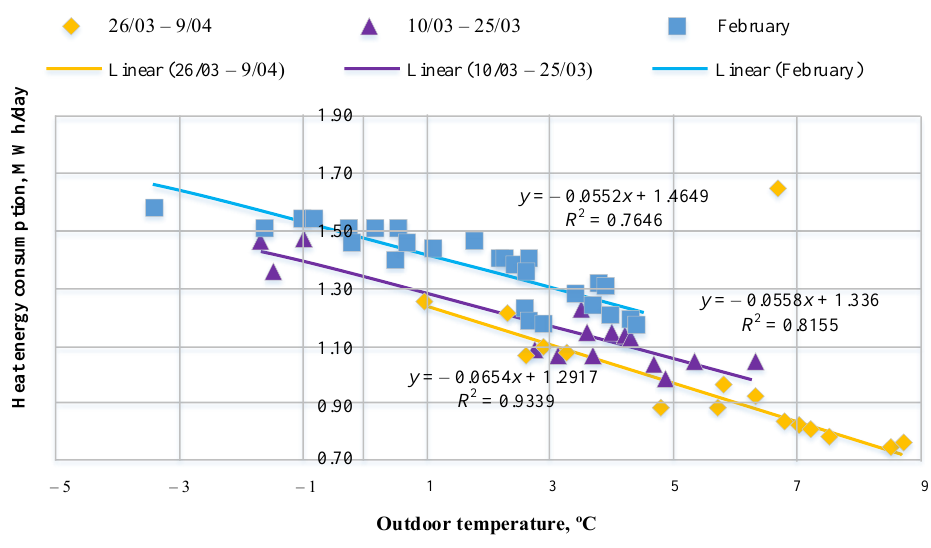
Fig. 8. Heat consumption depending versus outdoor air